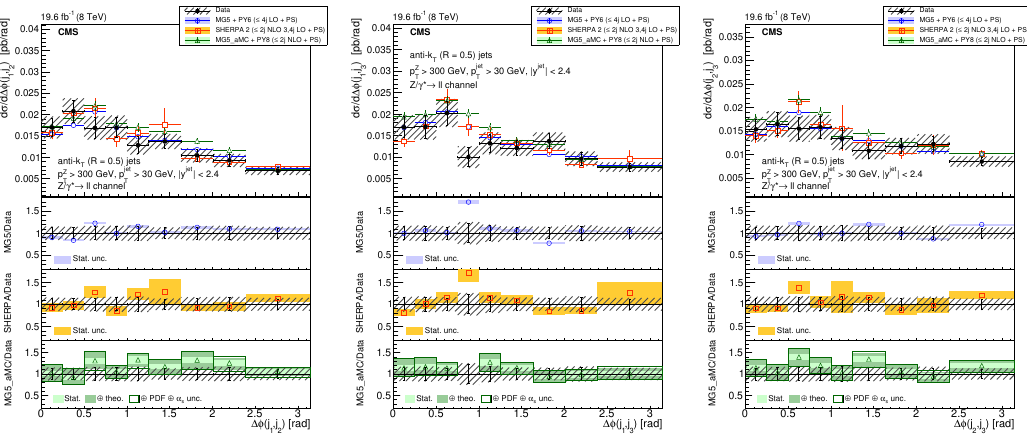
Figure 27 . The di(cid:11)erential cross section for Z ( ! ‘‘ ) + jets production for N jets (cid:21) 3 and p T (Z) > 300 GeV as a function of the azimuthal angle between (left) the (cid:12)rst- and second-, (mid- dle) the (cid:12)rst- and third-, and (right) the second- and third- leading-jets. The lower panels show the ratios of the theoretical predictions to the measurements. Error bars around the experimen- tal points show the statistical uncertainty, while the cross-hatched bands indicate the statistical and systematic uncertainties added in quadrature. The boxes around the mg5 a mc + pythia 8 to measurement ratio represent the uncertainty on the prediction, including statistical, theoretical (from scale variations), and PDF uncertainties. The dark green area represents the statistical and theoretical uncertainties only, while the light green area represents the statistical uncertainty alone.